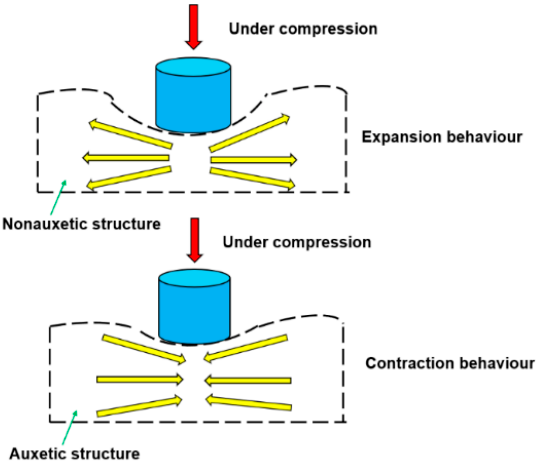
Figure 1. Different behaviours of nonauxetic structure and auxetic structures under compression.